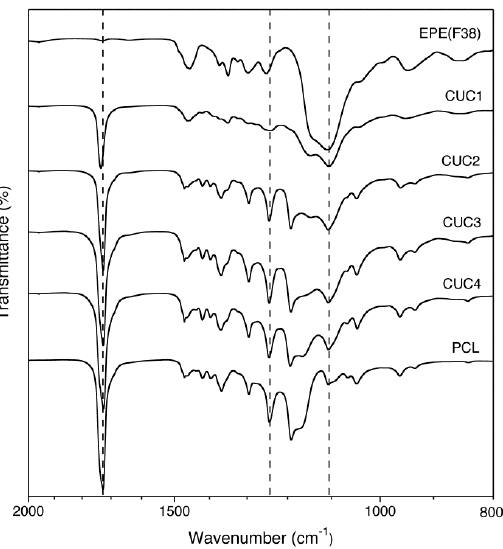
Figure 2. FT-IR spectra of CUC1-CUC4 pentablock copolymers, PCL, and EPE(F38).